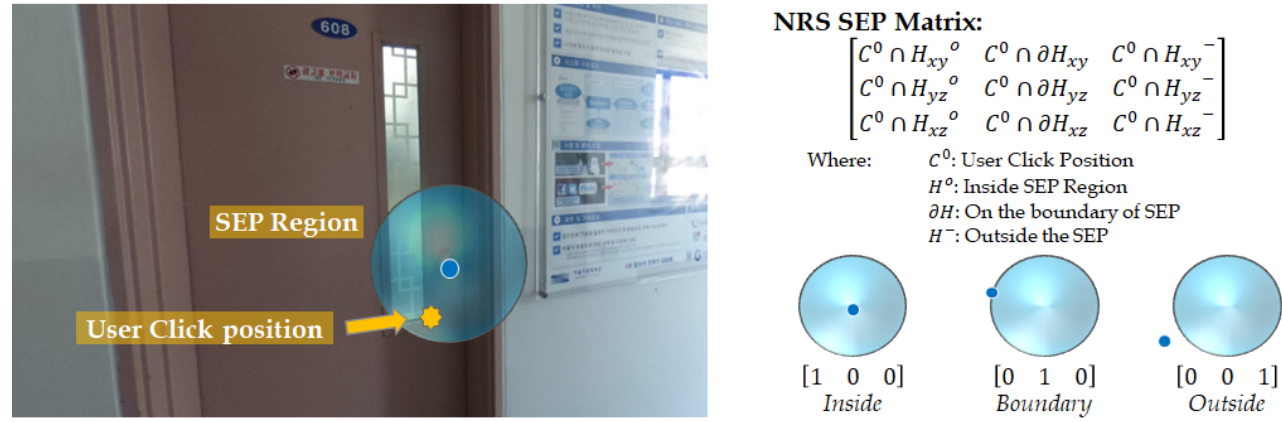
Figure 11. Detecting spaces and features from the images using user mouse input.